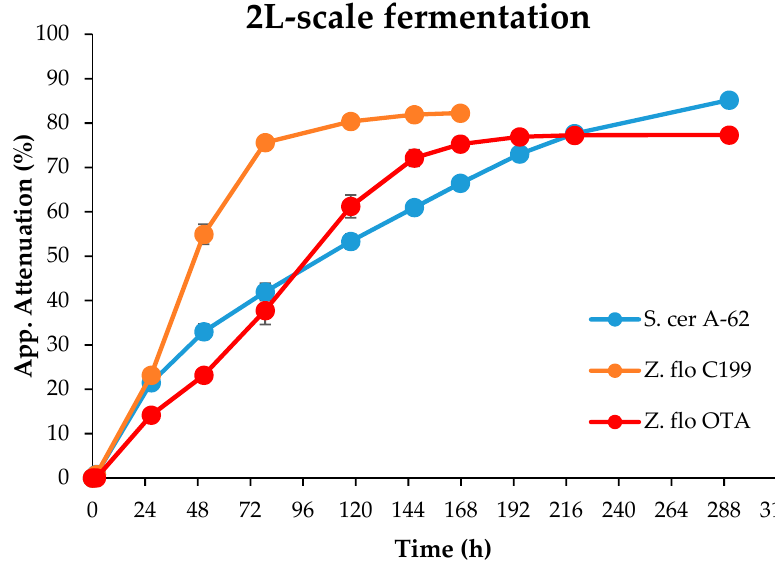
Figure 1. Progress of 2 L-scale fermentations (in 12 °P wort, at 20 °C) in relation to apparent attenuation. Values are the means from two independent fermentations. Error bars—when visible—represent the range between the duplicates. Table 2. Results of 2 L-scale fermentations in 12 °P wort at 20 °C. Volatile aroma values are all expressed as mg/L.